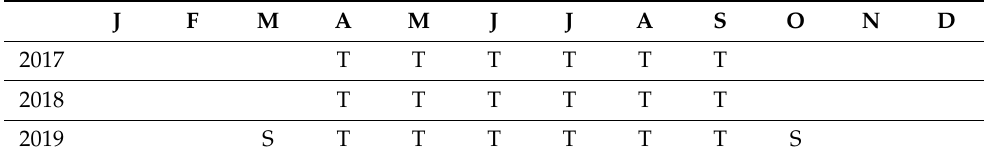
Table 1. Summary of the experimental trials with Dentamet ® treatments (T) and leaf sampling (S) periods over 2017, 2018 and 2019.